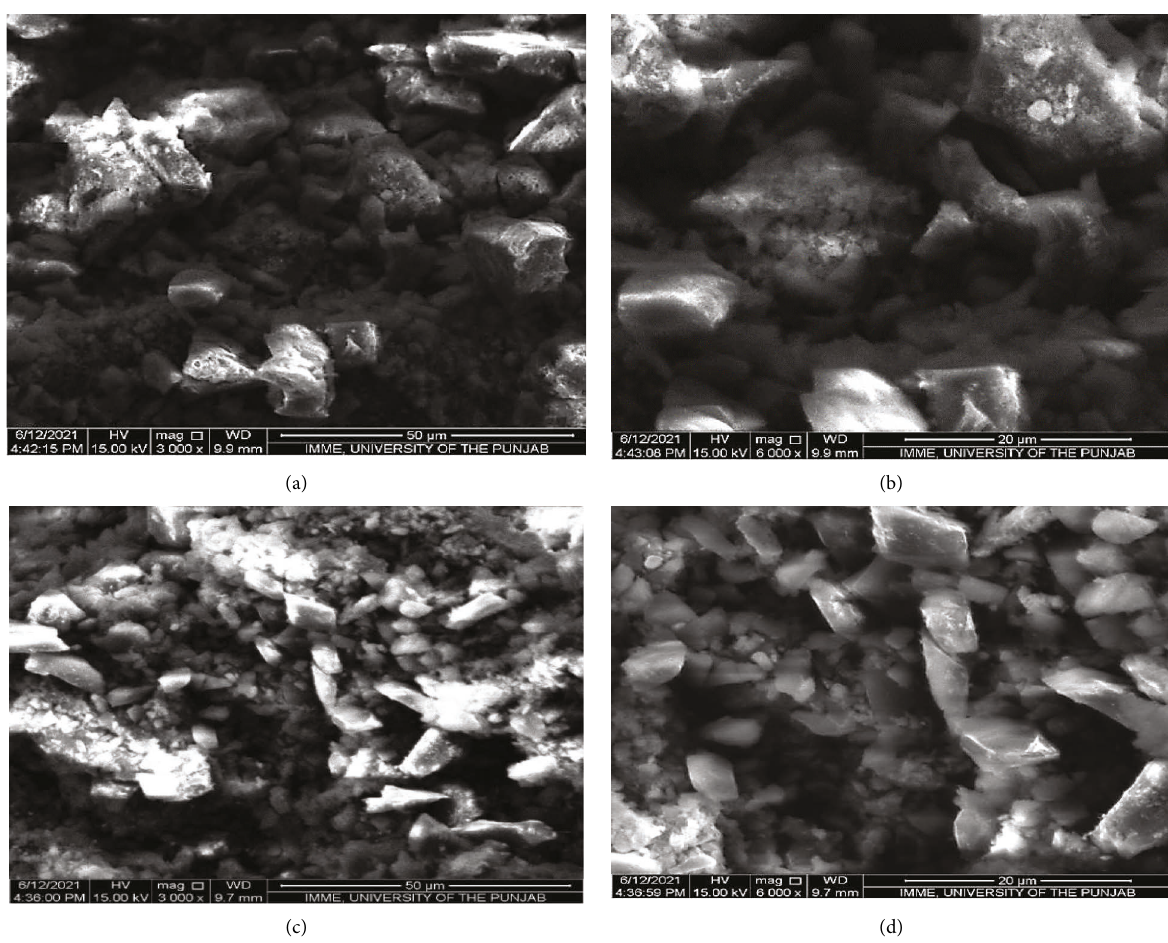
Figure 5: SEM micrographs of (a and b) complex (1), (c and d) complex (2) at different